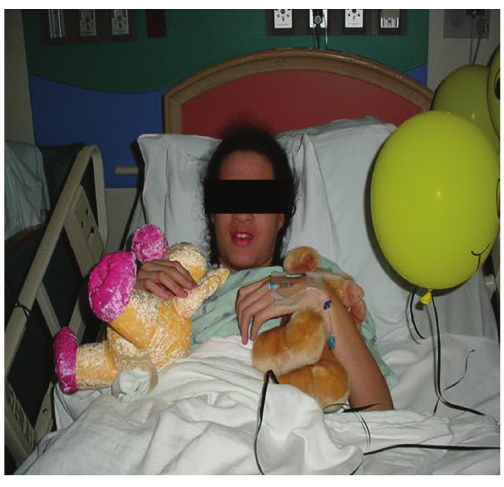
Figure 1: Dysmorphic facial features: high prominent forehead, long nose with a broad bridge, mild micrognathia, and short palpe- bral